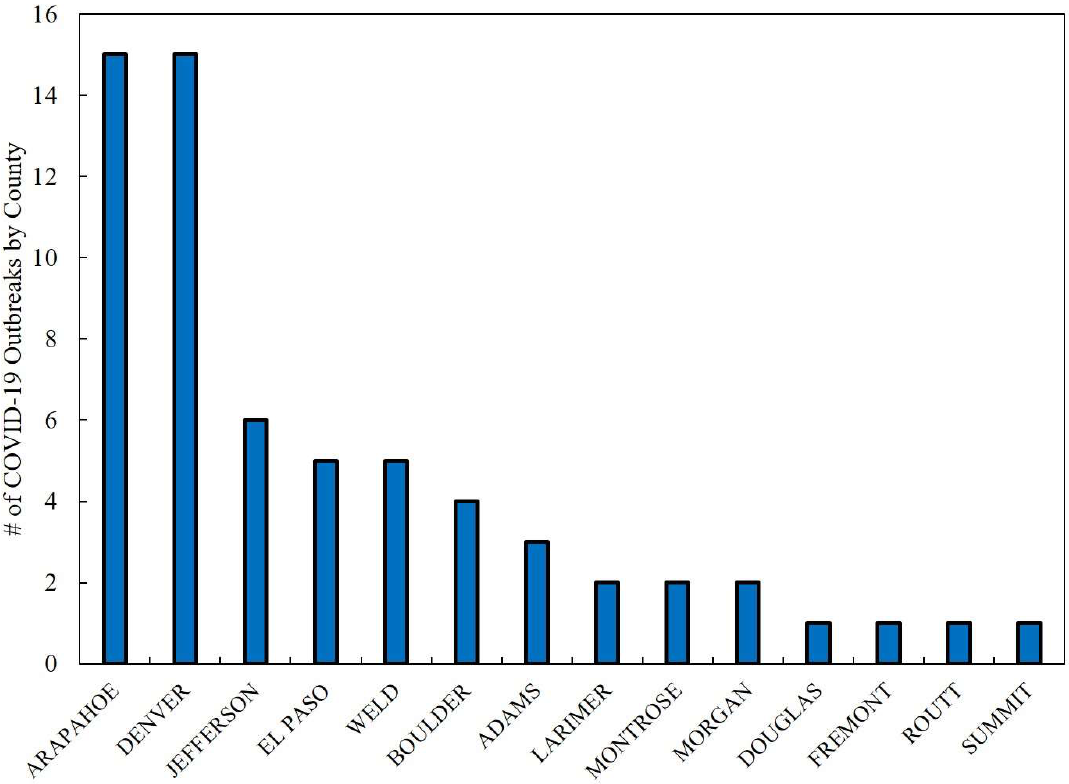
Figure 4. Number of COVID-19 outbreaks by county in Colorado. Outbreaks are associated with facilities such as seniors and assisted living, meat packing plants, and jails, from March 11 to April 8. Source: CDPHE [34].